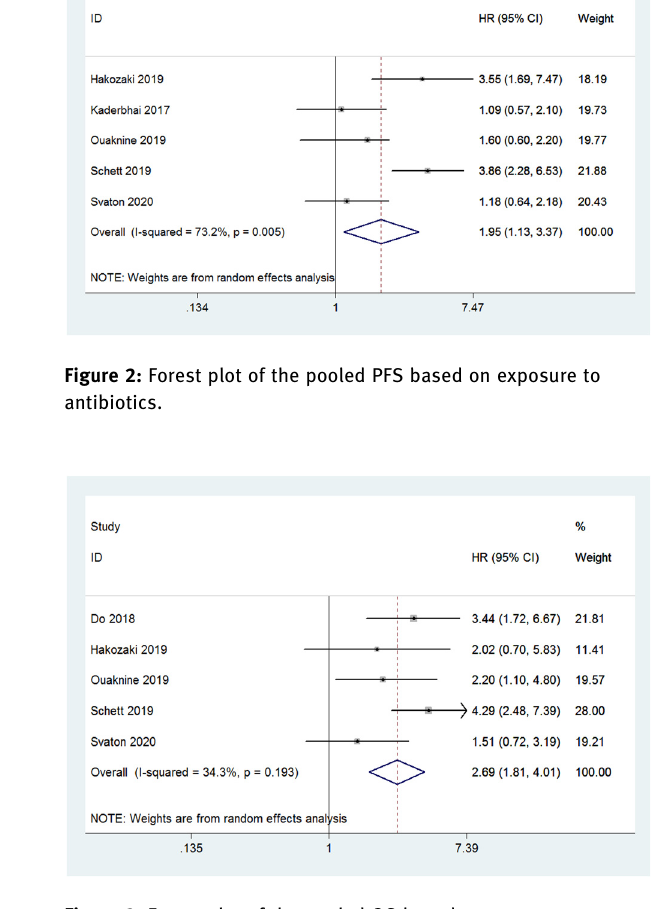
Figure 3: Forest plot of the pooled OS based on exposure to